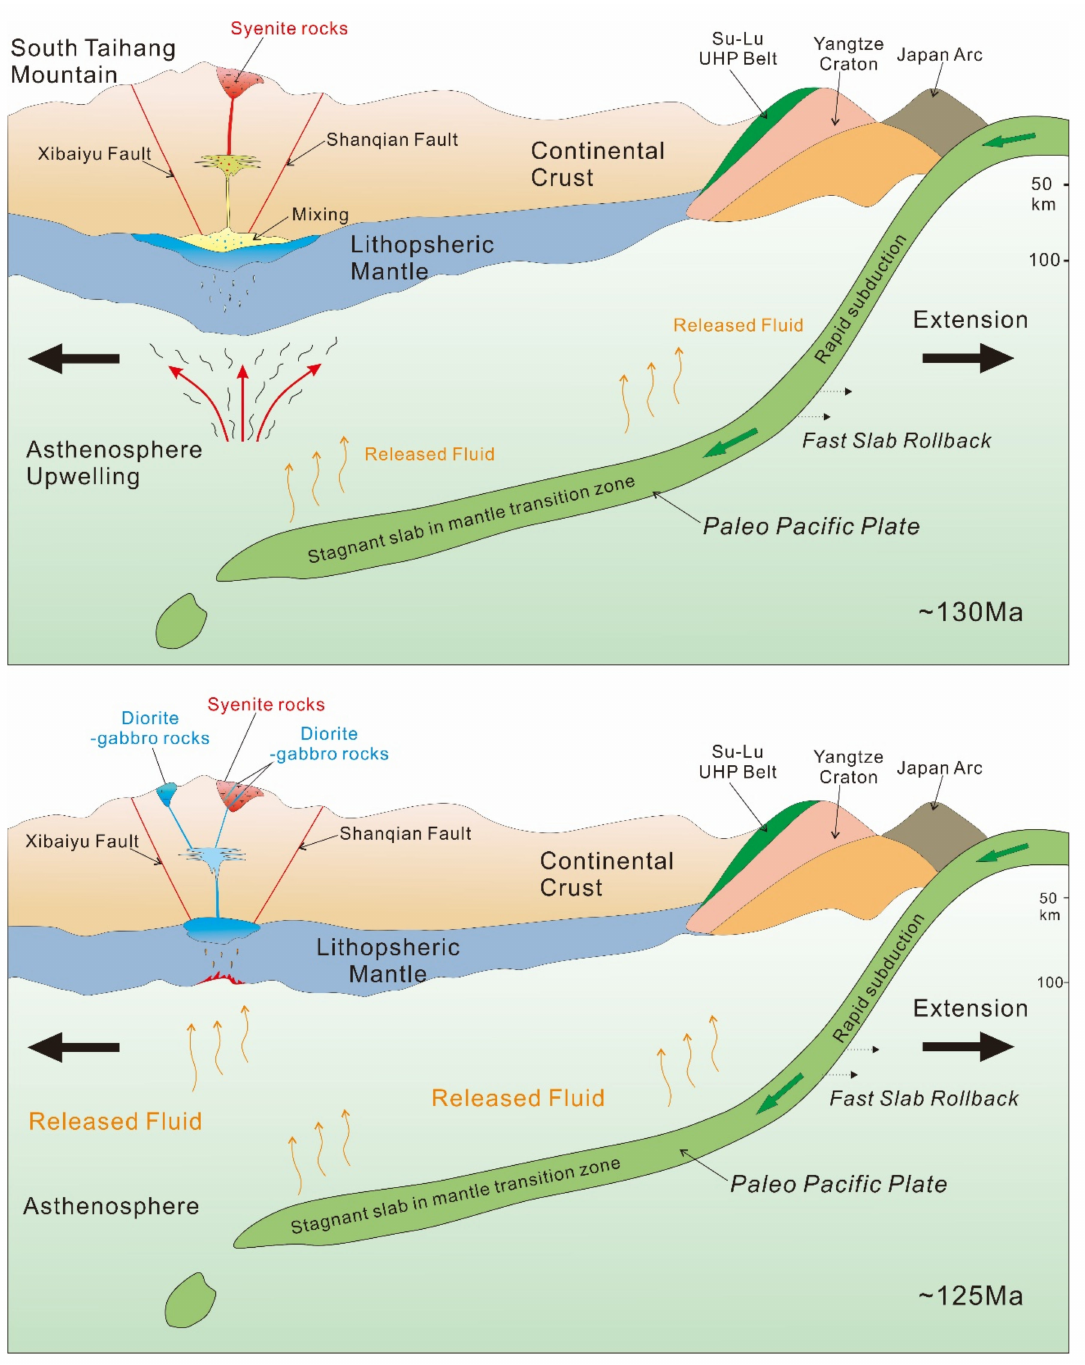
Figure 15. Tectonic model for the generation and emplacement of the Hongshan complex in the southern Taihang Mountains (modified after